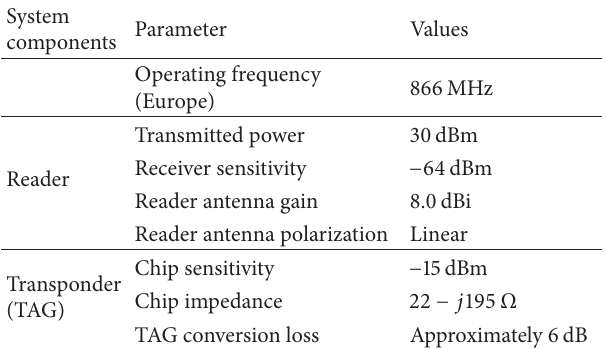
Table 2: Standard used UHF RFID system parameters.